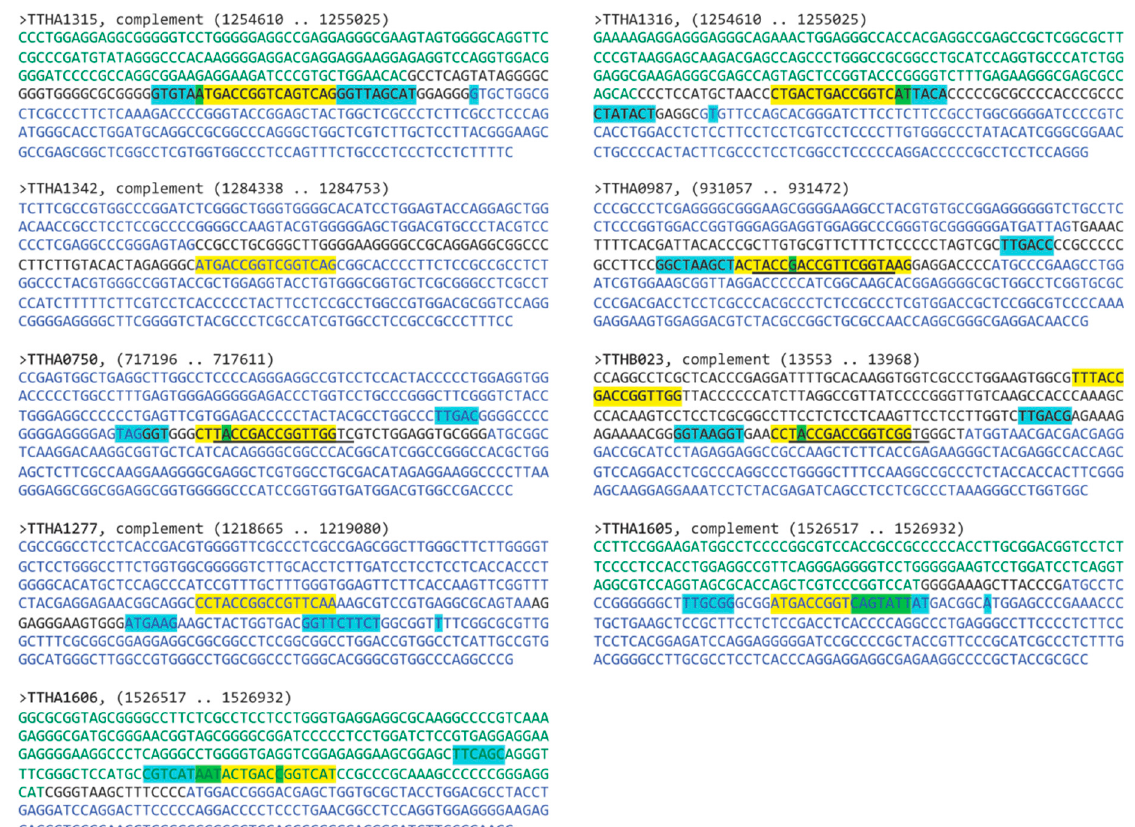
Figure 5. Bioinformatic identification of T. thermophilus HB8 promoters bound by TTHB023. Shown are sequences +/ − 200 bp of the Find Individual Motif Occurrences (FIMO)-identified TTHB023-binding sequence (see Table 2). Text colors indicate open reading frames with the same orientation as the target gene (blue nucleotides), intergenic sequences (blue nucleotides), and opposite-oriented open reading frames (green nucleotides). Highlighting indicates promoter elements (cyan highlighting), TTHB023-binding sites (yellow highlighting), and overlapping TTHB023-binding / core promoter elements (green